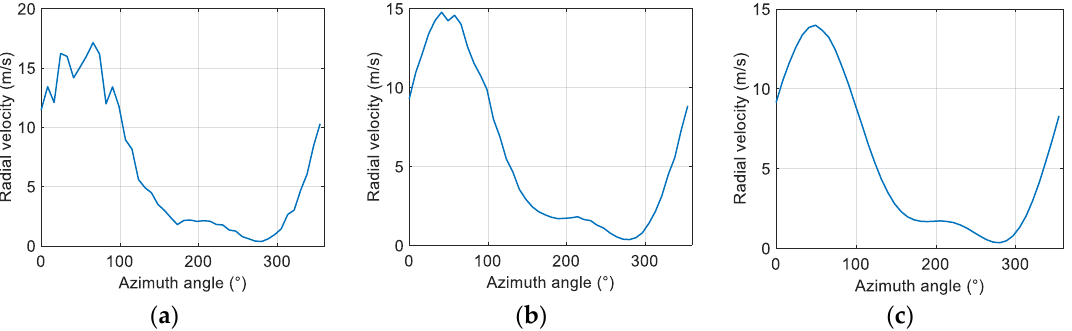
Figure 6. Variation of radial velocity with azimuth angle in linear wind field under different SNRs. ( a ) SNR = 5 dB; ( b ) SNR = 10 dB; ( c ) SNR = 20 dB.